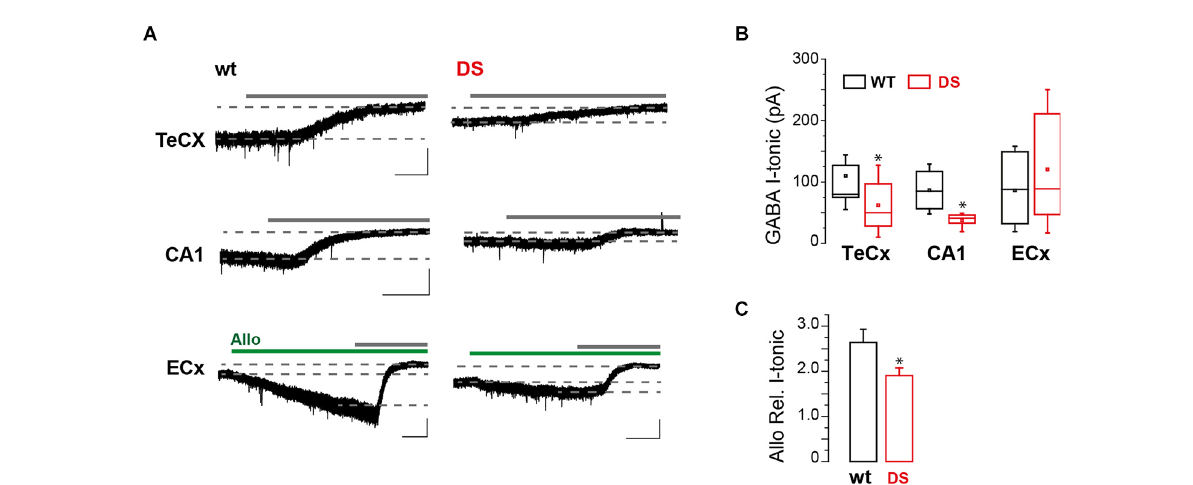
FIGURE1 GABA tonic currents are altered in DS mice during epileptogenesis. (A) Whole-cell recordings showing representative GABA tonic currents (I-tonic) evoked by blocking all GATs with nipecotic acid in perfusion (not indicated) and unmasked with a GABA A receptor antagonist (gray continuous lines; bicuculline or picrotoxin; see “Materials and methods” Section) in layer V pyramidal neuron of brain slices from 15 to 19 days old DS mice (Na v 1.1 +/- ) and same age littermate wild type controls (wt). Dotted lines indicate the I-tonic before and after GABA A receptor antagonist (gray bars; see “Materials and methods” Section). Green bars mark allopregnanolone (Allo) application. Scale bars, 1 min, 50 pA. (B) Box chart summarizing GABA I-tonic in wt and DS mice from TeCx ( n = 9 cells from three mice for wt and 11 cells from five mice for DS mice, p = 0.042, two sample t -test), CA1 ( n = 4 cells from four mice for wt and five cells from three mice for DS mice, p = 0.025, two sample t -test) and ECx ( n = 7 cells from four mice for wt and nine cells from four mice for DS mice, p = 0.399, two sample t -test). (C) Histogram summarizing the relative GABA I-tonic potentiation in ECx (mean ± SEM; same cells as in B ; p = 0.037, two sample t -test) induced by ALLO in wt and Na v 1.1 +/- mice. ∗ p ≤ 0.05, ∗∗ p ≤ 0.01, ∗∗∗ p ≤